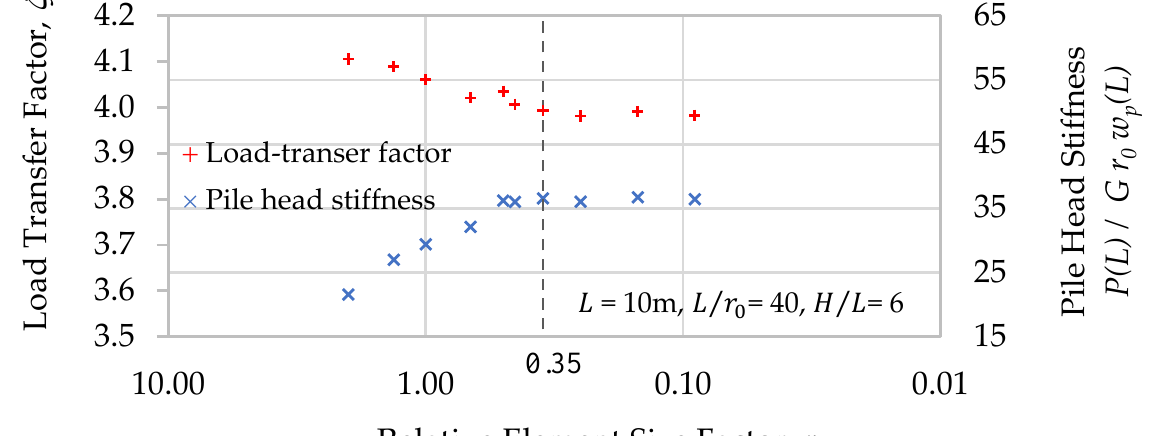
Figure 1. Load transfer factor and pile head stiffness versus relative element size factor.